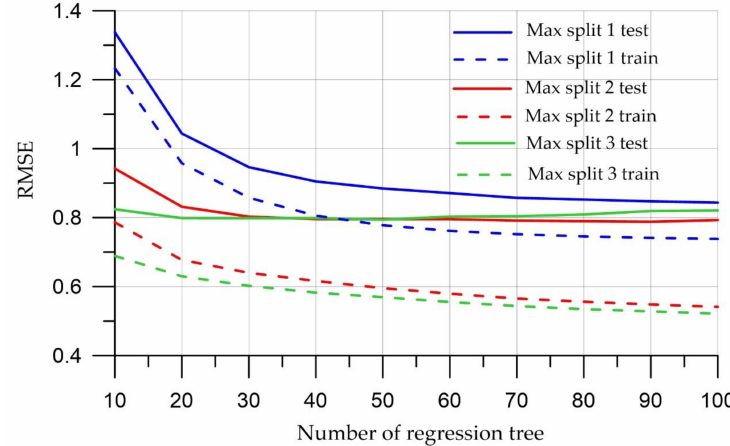
Figure 4. Meaning of Root-Mean-Square Error.